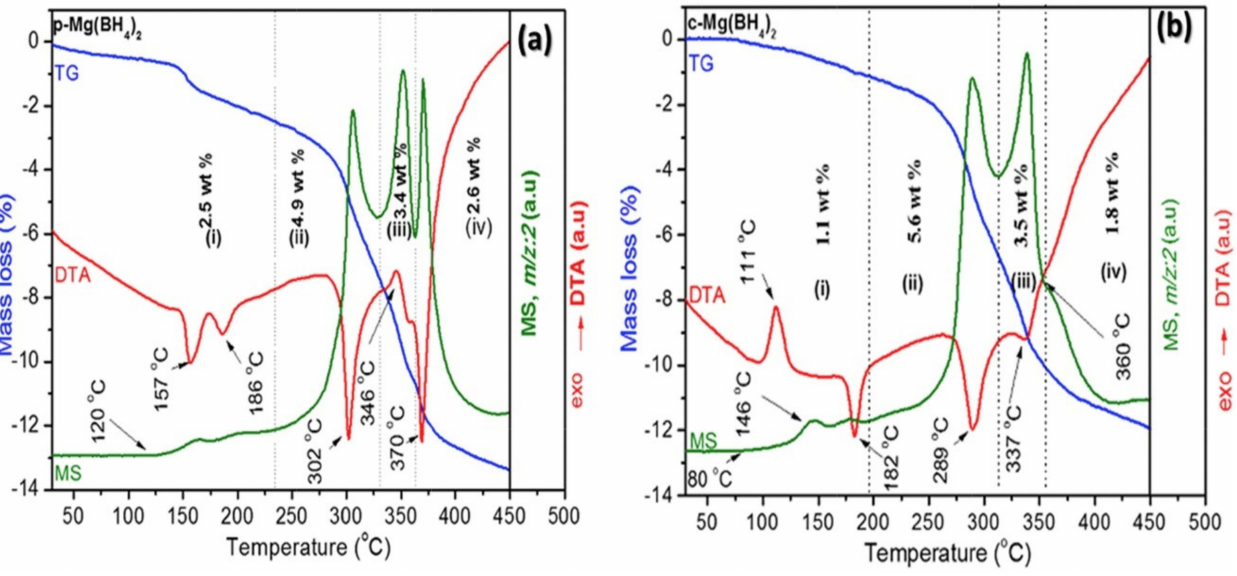
Figure 9. TG-DTA-MS measurements of ( a ) as-milled pure Mg(BH 4 ) 2 , and ( b ) as-milled ZrCl 4 - catalyzed Mg(BH 4 ) 2